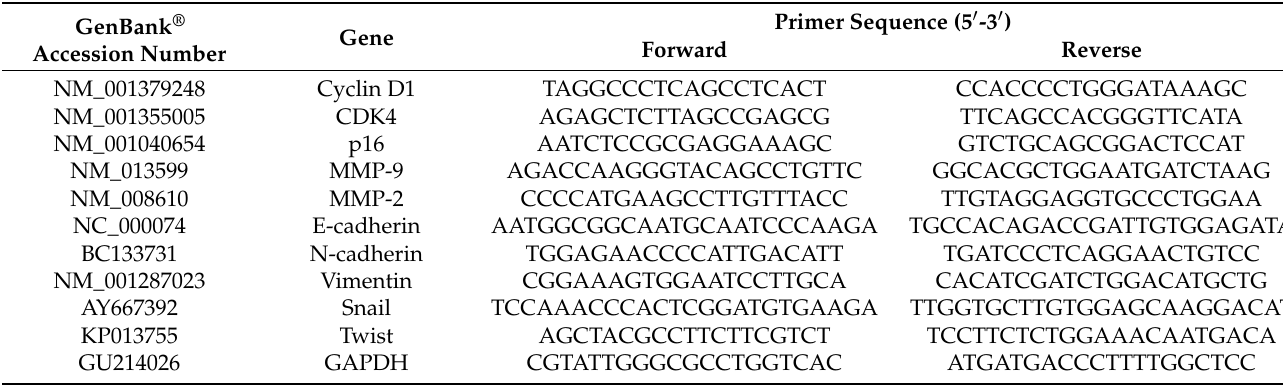
Table 1. Sequence of real-time RT-qPCR